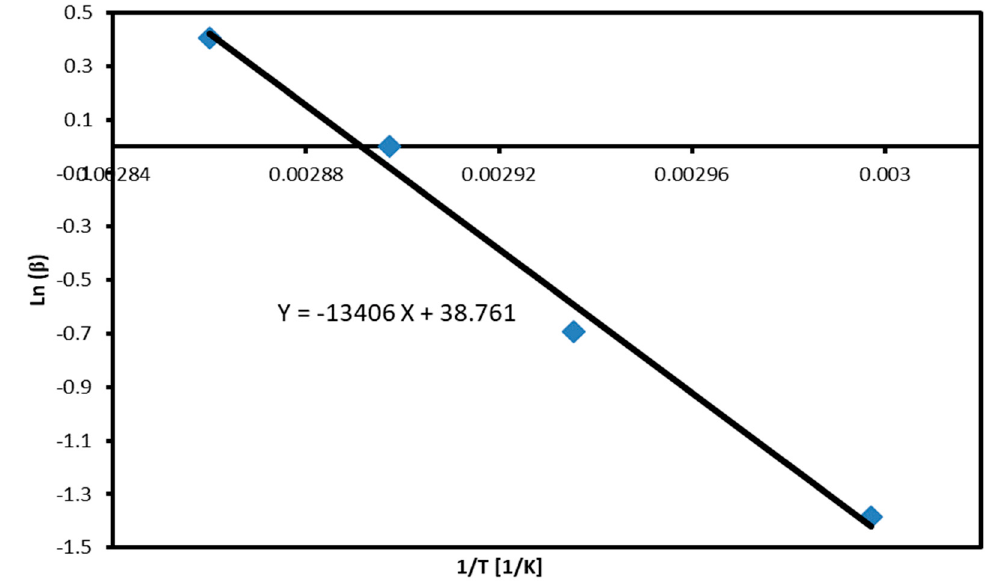
Figure 3. Plot of ln( β ) versus the inverse of the absolute onset temperatures according to the Ozawa method.